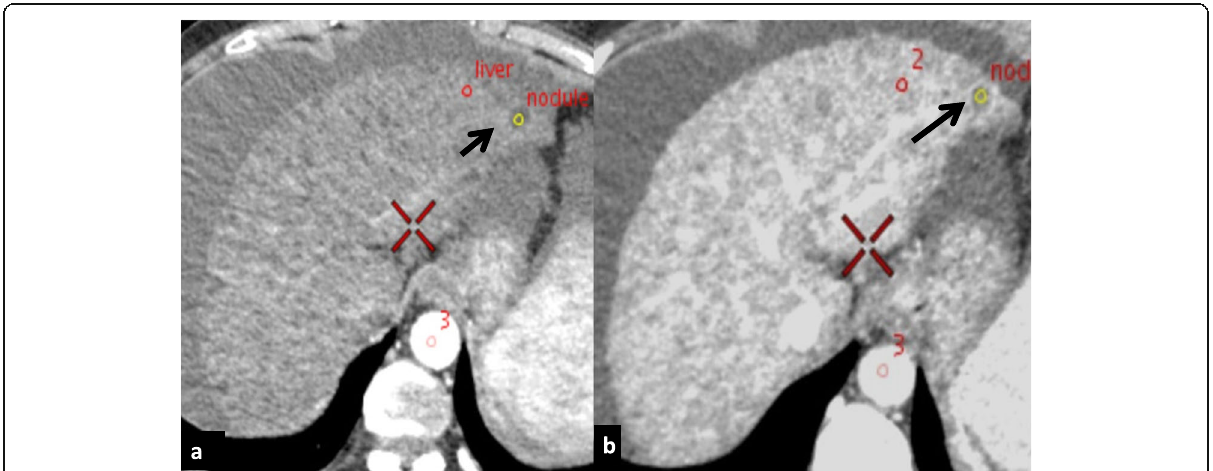
Fig. 3 Computed tomography of a patient with underlying cirrhosis depicting ‘ regenerative ’ nodule. a Polychromatic axial image on HAP showing a well-defined subcapsular non-enhancing lesion (yellow ROI), in segment II (black arrow). b Polychromatic PVP image shows persistent non-enhancement of the same lesion (yellow ROI) in segment II (black arrow) ICD ), normalised iodine concentration (NIC = ICD- liver /ICD ) and difference in ICD ( Δ ICD = ICD nodule aorta HAP − ICD PVP). The NIC was measured as a nodule